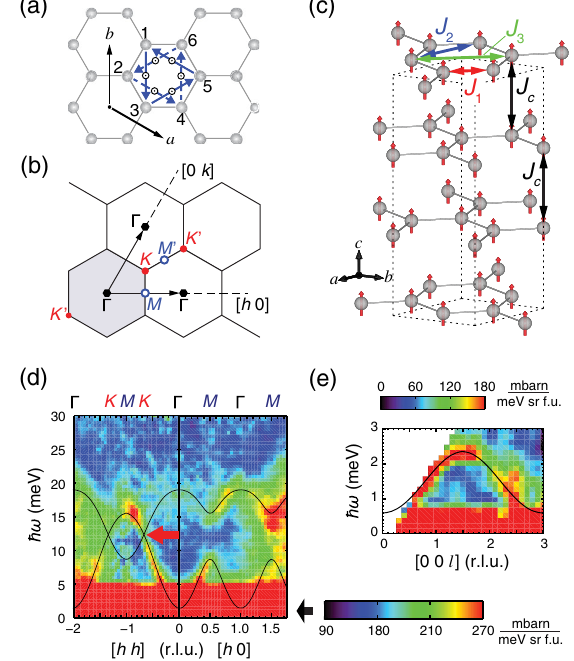
FIG. 1. (a) Top view of the honeycomb lattice and the out-of- plane components of the antisymmetric DM vectors. The triangular arrows mark the second nearest-neighbor bond ori- entations that share the common sign of DM vectors. (b) The BZ zone boundaries and the high symmetry points on the ð h; k Þ plane. (c) Crystal and magnetic structures of CrI 3 with the Heisenberg exchange paths. Iodine sites are not displayed for simplicity. The dotted lines denote the hexagonal unit cell boundary. (d) Inelastic neutron scattering results of spin waves ¼ 50 meV along the high symmetry directions in the with E i ð h; k Þ plane, which are observed at 5 K and integrated over − 5 ≤ l ≤ 5 . The superimposed solid lines are the calculations by the Heisenberg-only model. (e) Low-energy spin-wave mode ¼ 8 meV). Note that the minima appear along the l direction ( E i at l ¼ 3 n in the hexagonal setting. The data are normalized to the absolute units of mbarn/meV/Sr/f.u. (f.u. is formula unit) by a vanadium